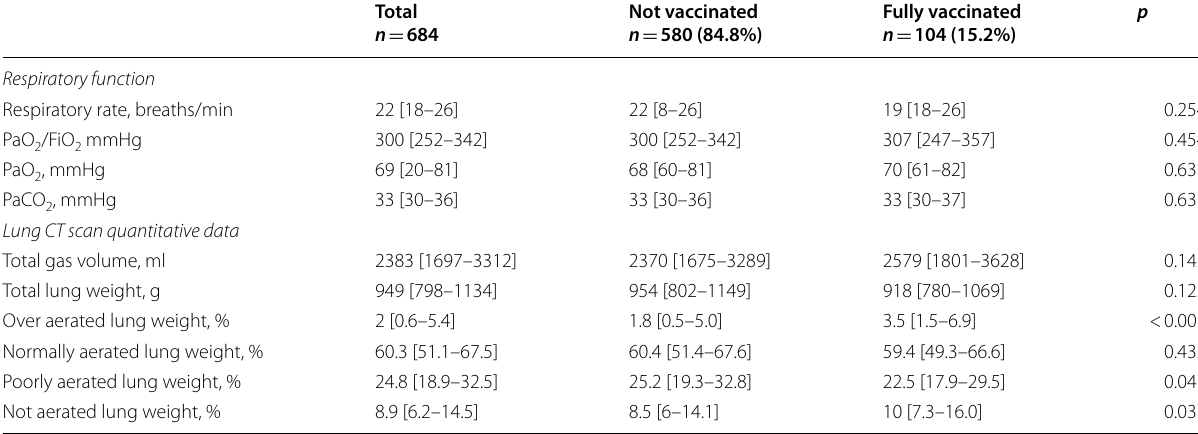
Continuous variables are expressed as median [IQR] and compared with Mann–Whitney U test.